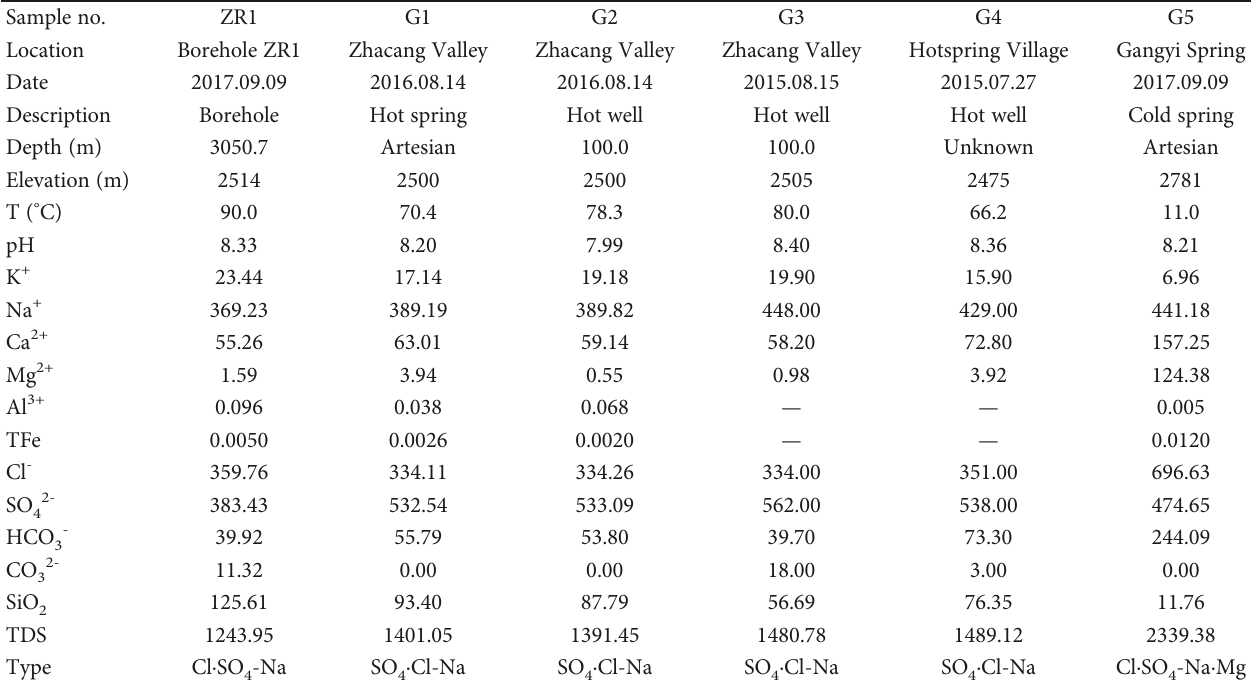
Table 1: Water chemistry and temperatures in recharge and discharge waters from the Zhacang geothermal fi eld of Guide Basin (mg/L). The temperature of ZR1 refers to the sampling temperature (90 ° C); the bottom temperature is measured at 151.34 ° C. Sample